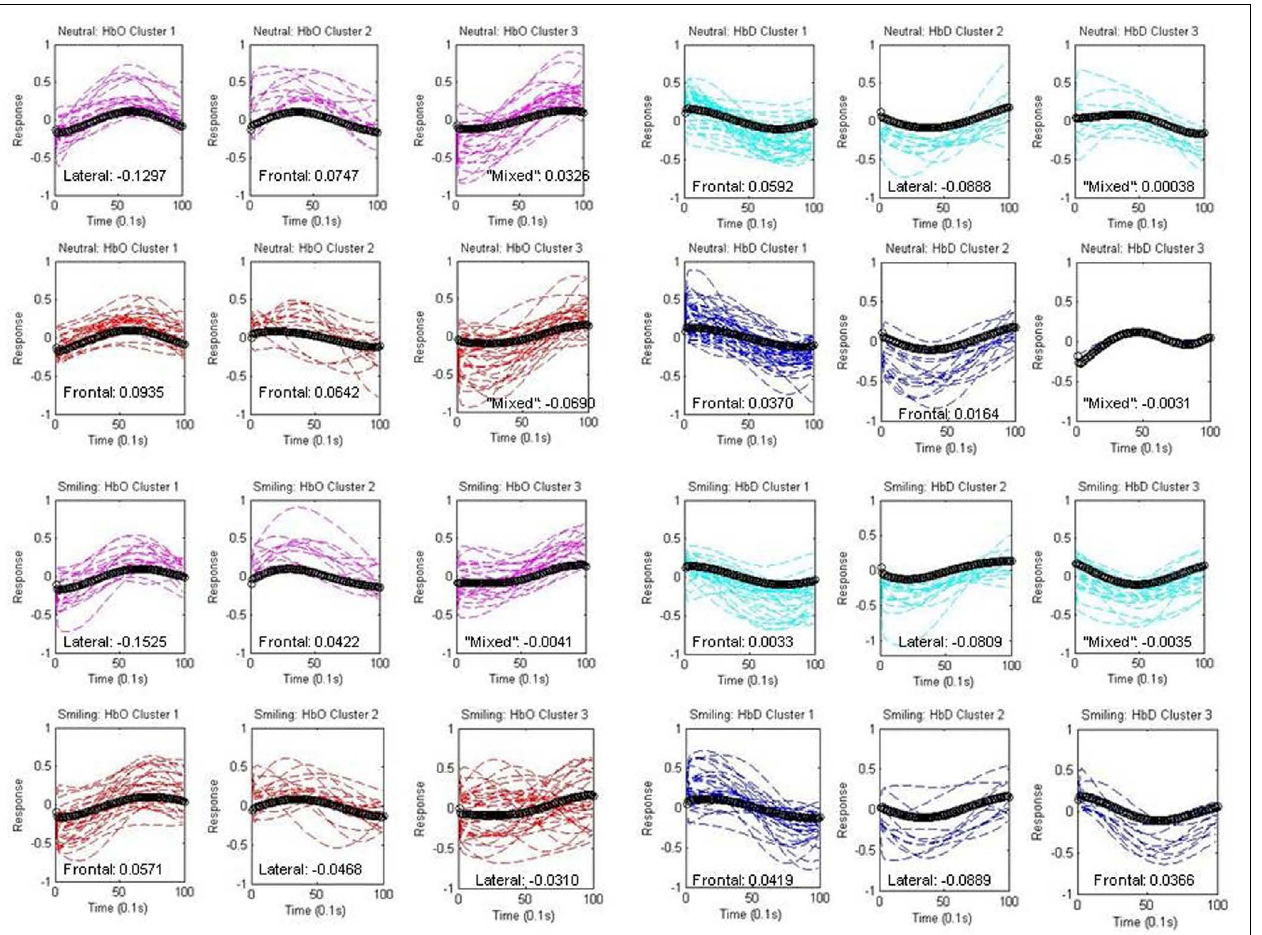
(HbD) are shown in blue (HRA) and cyan (LRC).The spatial assignment by laterality index is indicated as “frontal,” “lateral,” or “mixed” for each cluster, and numeric differences in mean normalized weight across regions are given